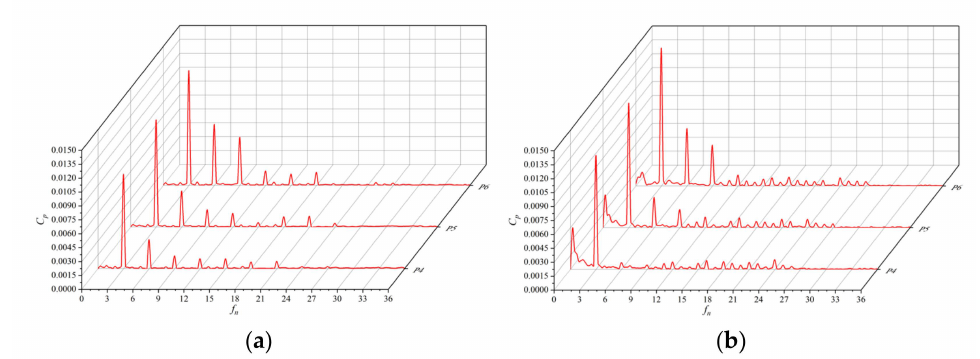
Figure 16. Frequency domain of pressure pulsation at impeller outlet ( Q = Q d ): ( a ) shaft front positioned tubular pump device; ( b ) shaft rear positioned tubular pump